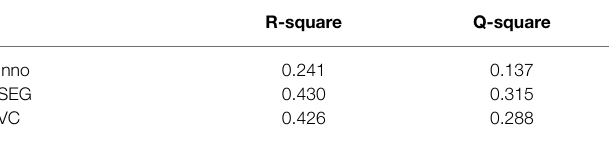
TABLE 4 | R-square values for the variables.